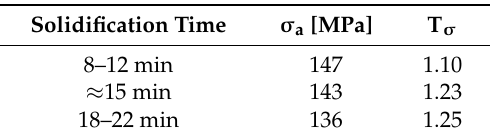
Figure 7. Fatigue life of specimens as a function of solidification time. Lines represent the estimated 50% survival probability curve in the defined solidification time ranges. Run out specimens marked with an arrow. Table 5. Fatigue strength at 50% survival probability and scatter index at 10 7 cycles considering solidification time range.